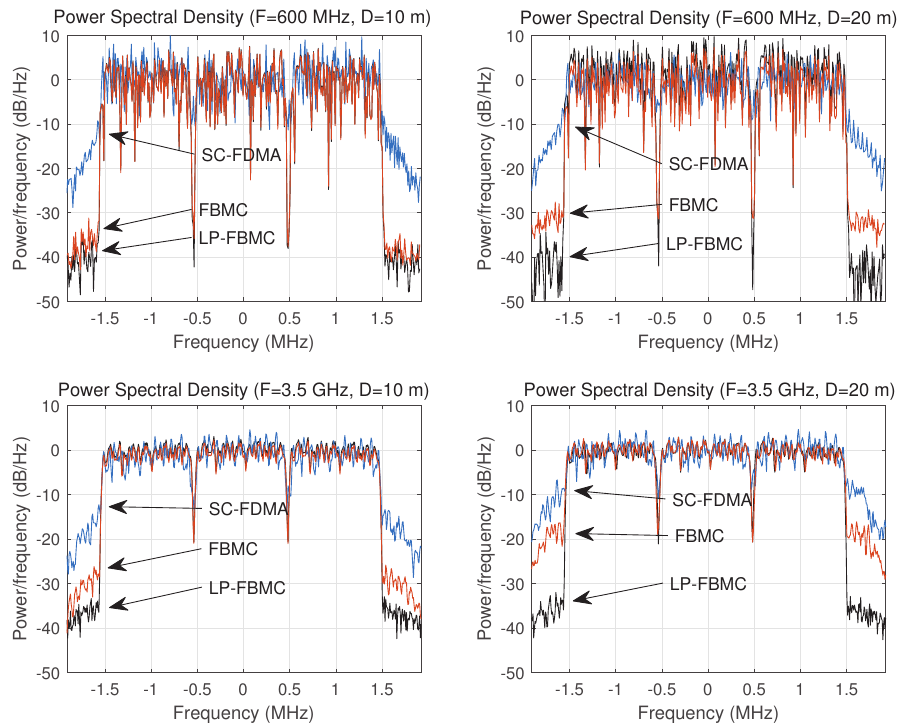
Figure 7. Power spectra of the SC-FDMA , FBMC, and LP-FBMC, K = 3, N = 64, LoS environment, ∆ f = 15